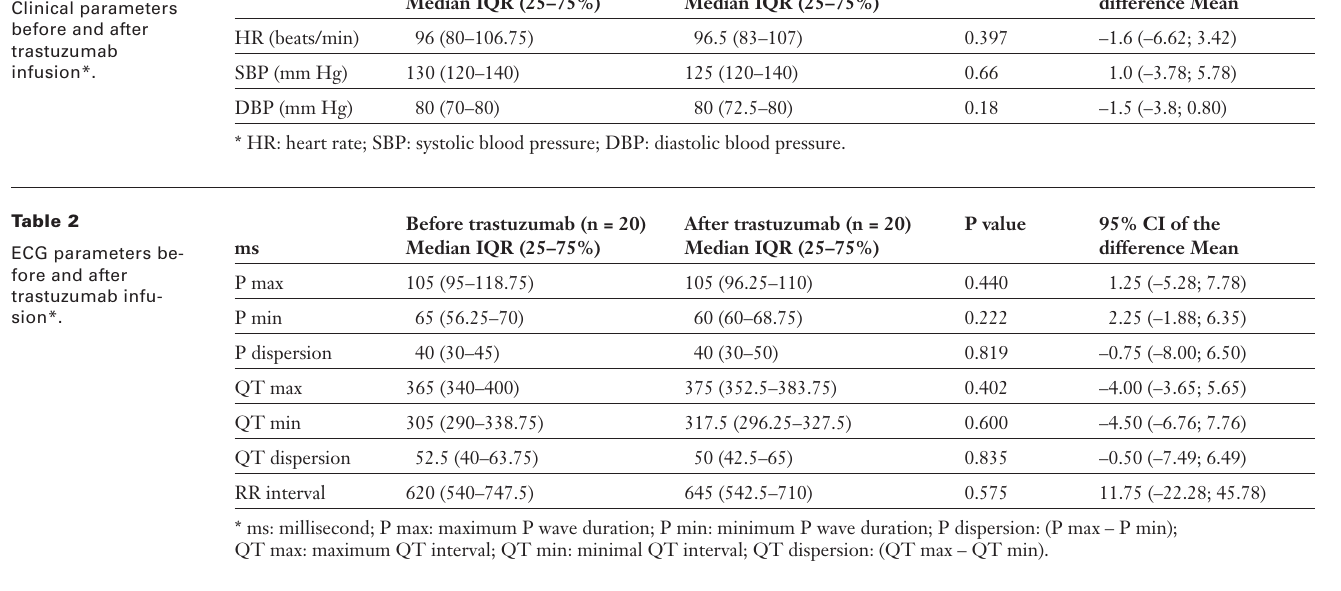
Clinical parameters before and after trastuzumab infusion*.